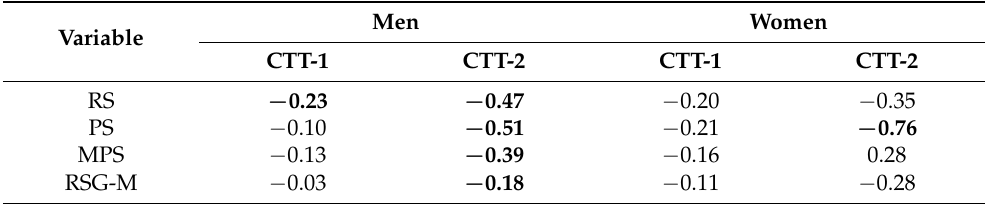
Table 2. Spearman correlation results between the study variables. Correlation coefficients in bold are significant with p <